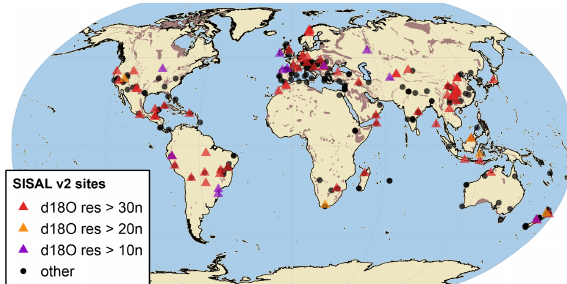
Figure 2. Site locations of the SISAL database on a global karst map (brown shadings from Williams and Ford, 2006). The sites with entities that fulfill the prerequisites for our analysis are marked in colored triangles. These entities cover at least a period of 600 years within the last millennium and have a minimum of 30 (red), 20 (or- ange), or 10 (purple) δ 18 O measurements and two dating points in this period. All other sites in the SISAL database v.2 are marked with a black dot. The nine clusters used in the network analysis contain sites in North America (c1, 12 entities), South America (c2, 12 entities), Europe with northern Africa (c3, 21 entities), southern Africa (c4, 2 entities – too few for systematic analysis), the Middle East (c5, 6 entities), India and central Asia (c6, 8 entities), East Asia (c7, 18 entities), Southeast Asia (c8, 3 entities), and New Zealand (c9, 3